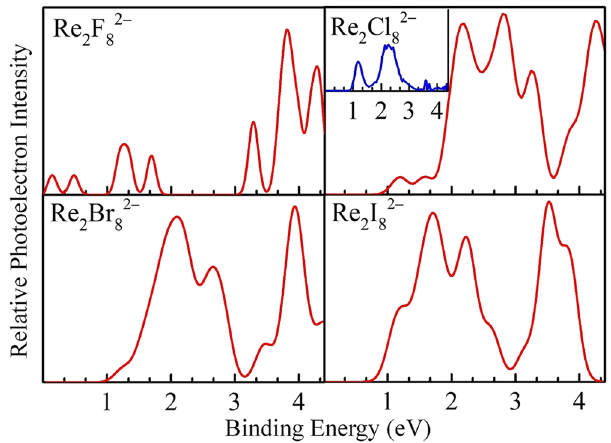
Figure 2. The simulated photoelectron spectra of the ground-state structures of Re 2 X 82 − (X = F, Cl, Br, I) clusters, along with the available experimental spectrum of Re 2 Cl 82 − in the inset.